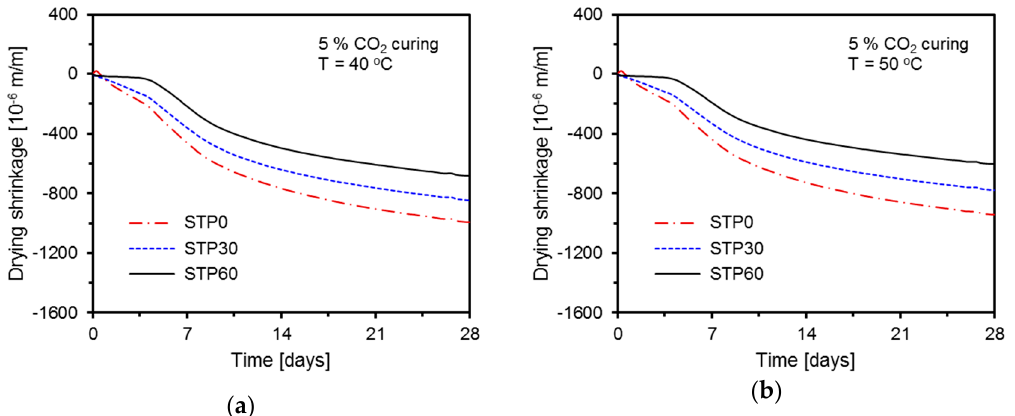
Figure 6. Drying shrinkages according to curing temperature: ( a ) 40 °C and ( b ) 50 °C. Table 3. 28-day drying shrinkage according to the curing conditions.